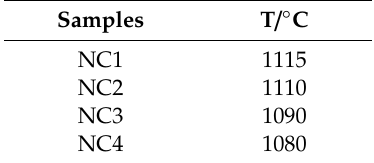
Figure 2. Thermal loading history for the simulation model including three steps. Table 4. Temperature parameters of thermal shock test at the bottom of substrate.